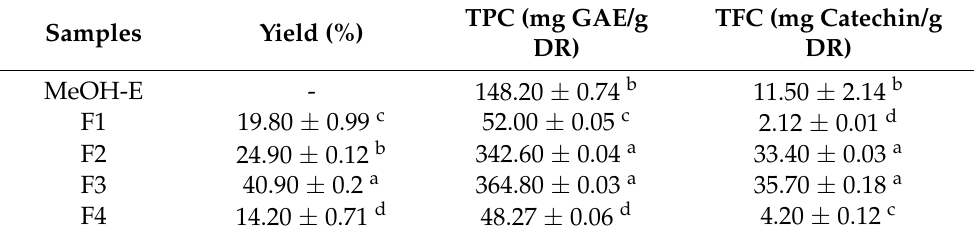
Table 1. Total contents of phenolic compounds (TPC) and flavonoids (TFC) of Retama raetam methano- lic extract (MeOH-E) and the subsequent fractions (F1, F2, F3, F4).